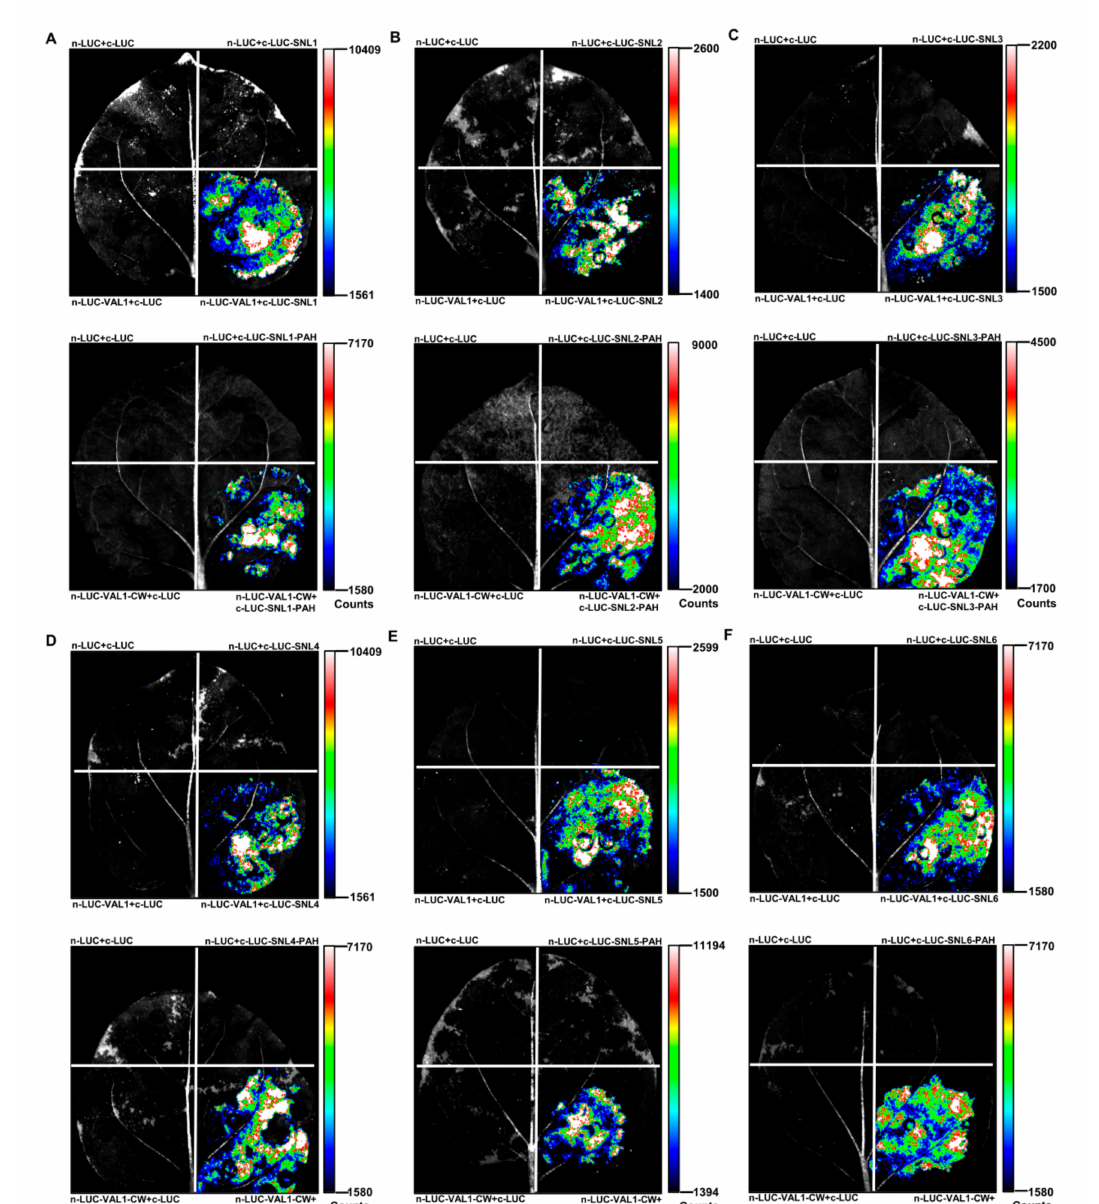
Figure 3. LCI assay verified that VAL1 interacts with SNLs through the CW domain of VAL1 and the PAH domains of SNLs in tobacco. ( A – F ) VAL1 interacts with SNLs (SNL1–SNL6), and its CW domain (aa 458–673) interacts with the PAH domains of SNL1 (aa 1–450), SNL2 (aa 1–430), SNL3 (aa 1–390), SNL4 (aa 1–420), SNL5 (aa 1–250) and SNL6 (aa 1–300) in the leaf epidermal cells of N. benthamiana . The intact and CW domain of VAL1 were fused to the n-LUC fragment, and the intact and PAH domains of SNLs ( SNL1 – SNL6 ) were fused to the c-LUC